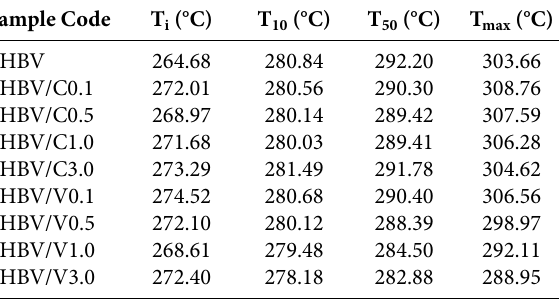
Table 3. TGA values of PHBV/ CaCO 3 composites and neat poly- mer Sample Code